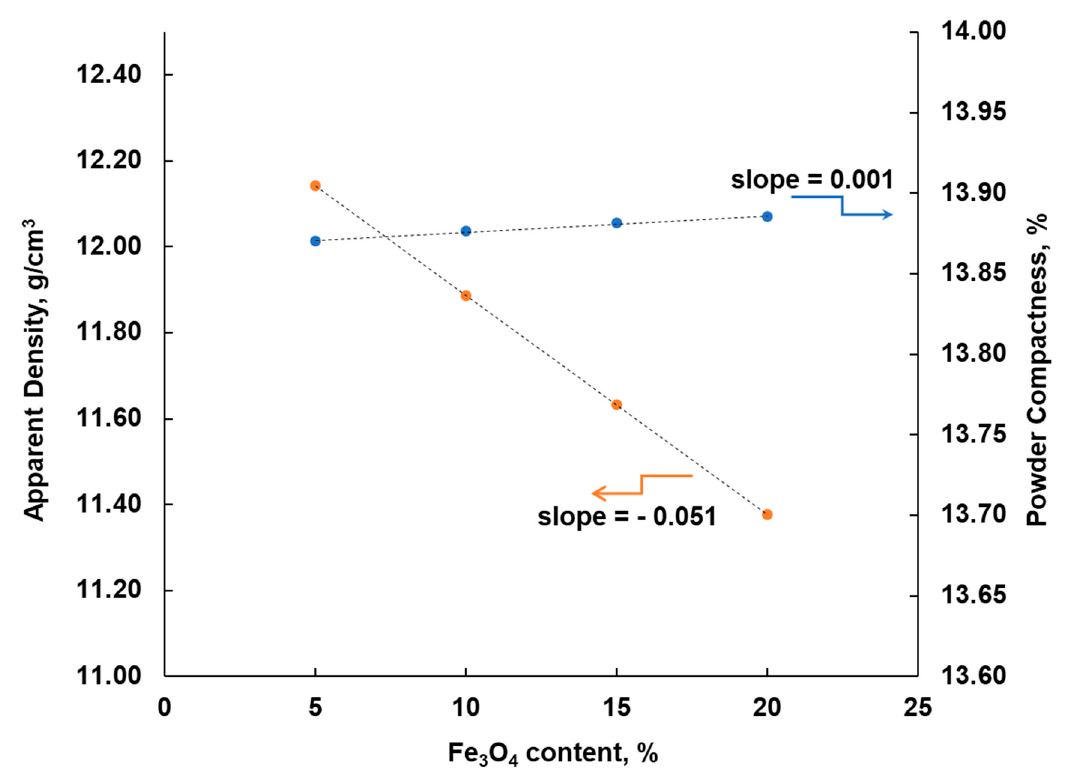
Figure 3. Variation of apparent density and powder compactness with the Fe 3 O 4 content in the powder blend.